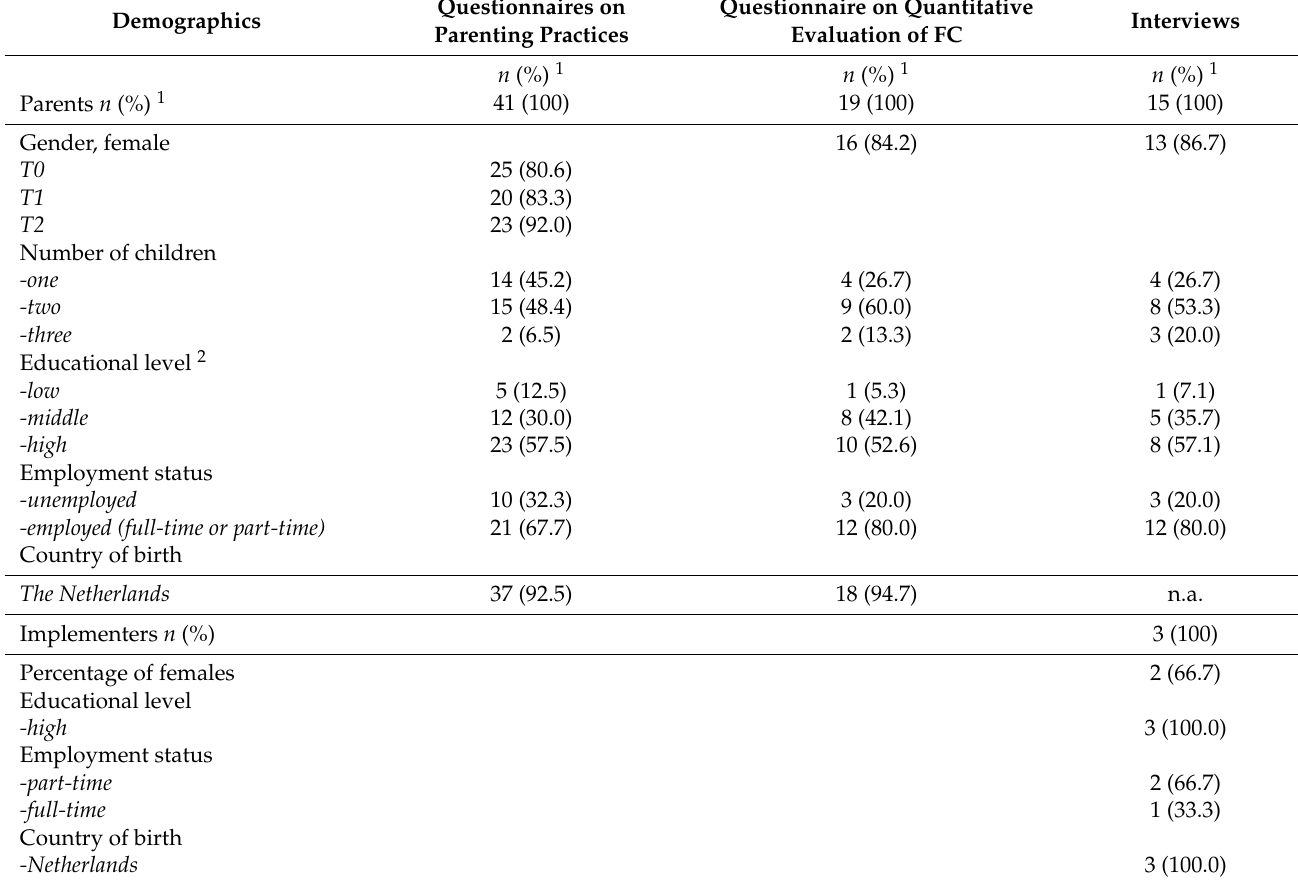
Table 2. Participant samples and